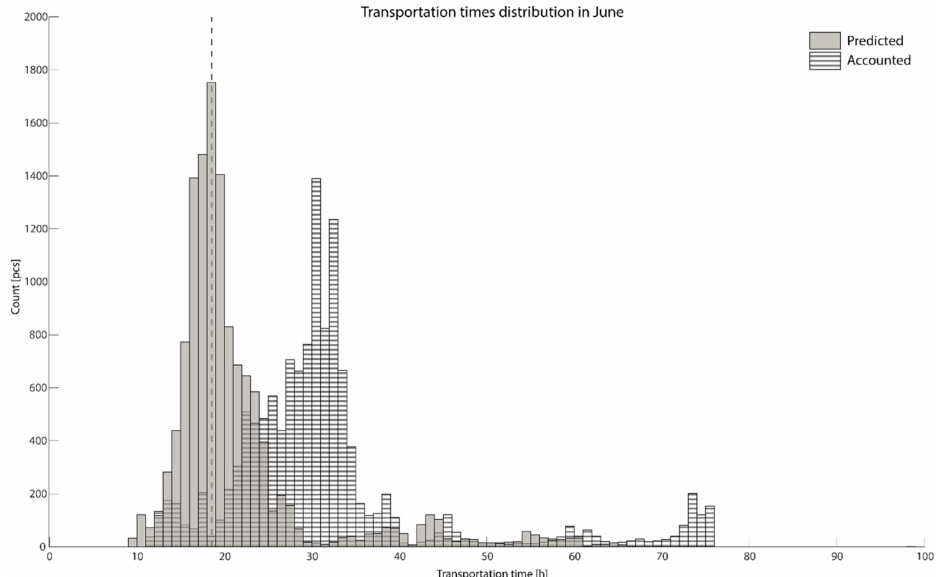
Figure 13. Distribution of the transportation times. The dashed line is the calculated average, grey represents the predicted times, and striped represents the accounted transportation times in